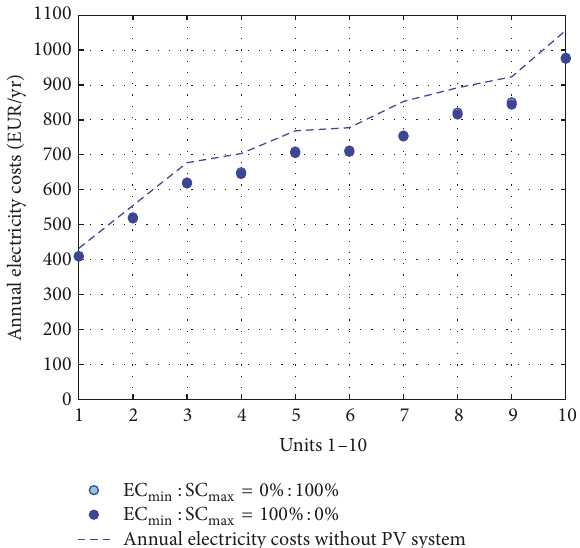
Figure 5: German retail electricity prices: annual electricity costs for the individual apartments calculated for different weighting of objective functions.